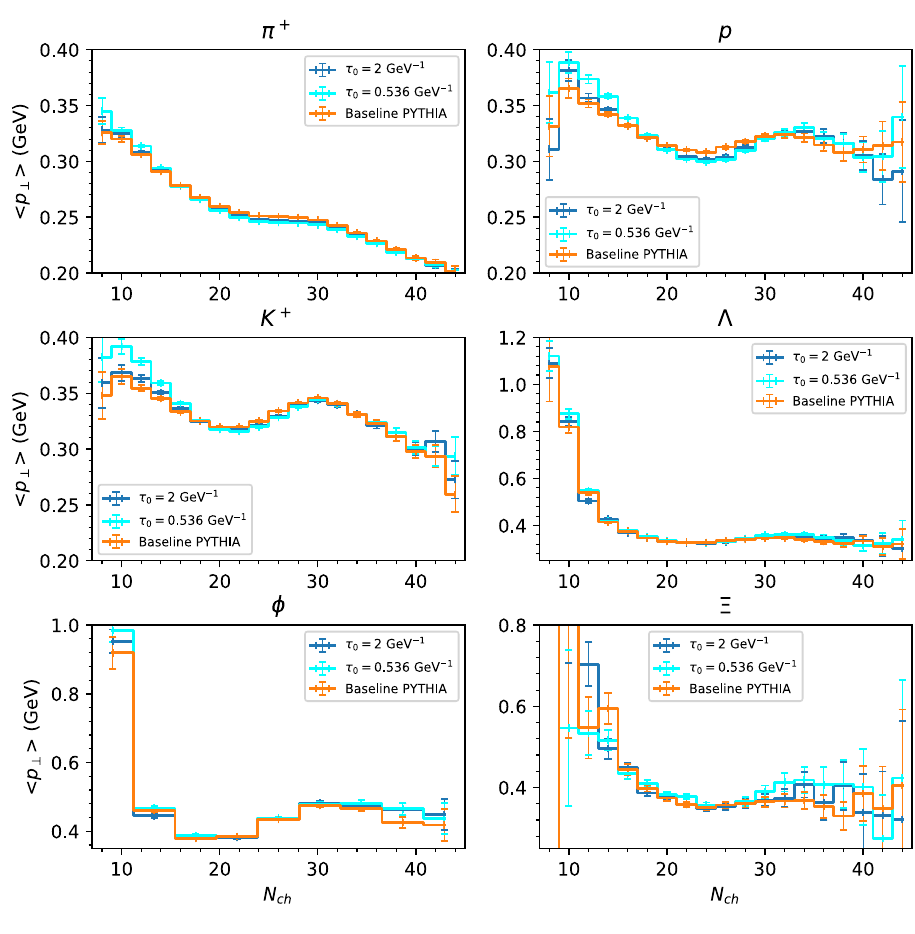
Fig. 8 Mean p ⊥ along thrust major axis versus charged multiplicity for π + , p , K + , (cid:14) , φ and